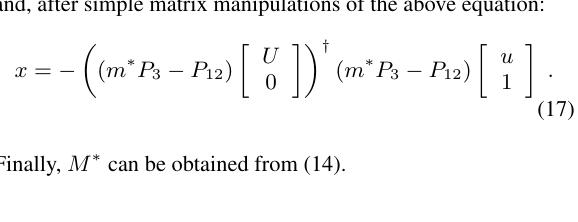
Figure 7: Example of segmentation results, corresponding to the image in Fig. 1. The region considered for the analysis is de- limited by the green lines, whereas boundaries of the segmented areas are indicated by red lines.